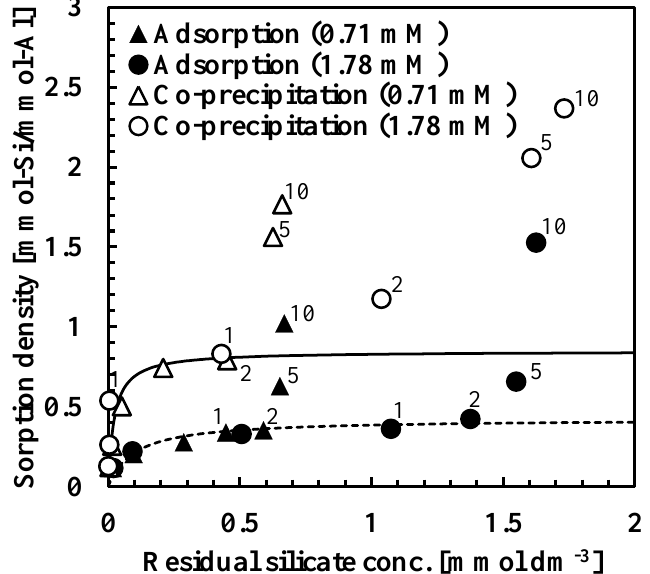
Figure 2. Sorption isotherm obtained from co-precipitation and adsorption experiments at pH 9. The initial silicate concentration was either 0.71 or 1.78 mmol·dm −3